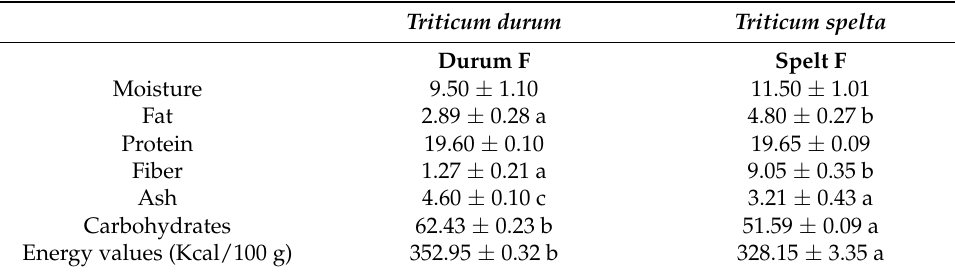
Table 2. Proximal analysis of pastas from different cereals with fish concentrate added.